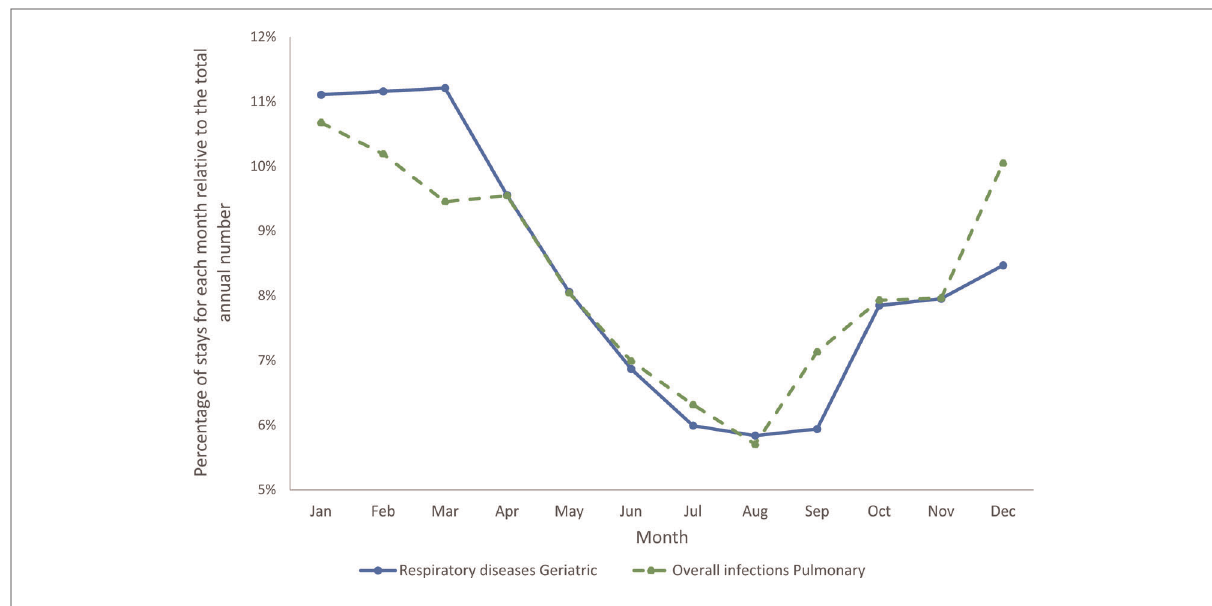
FIGURE 10 Cumulative seasonality trends for overall infections in the pulmonary ward and for respiratory diseases in the geriatric